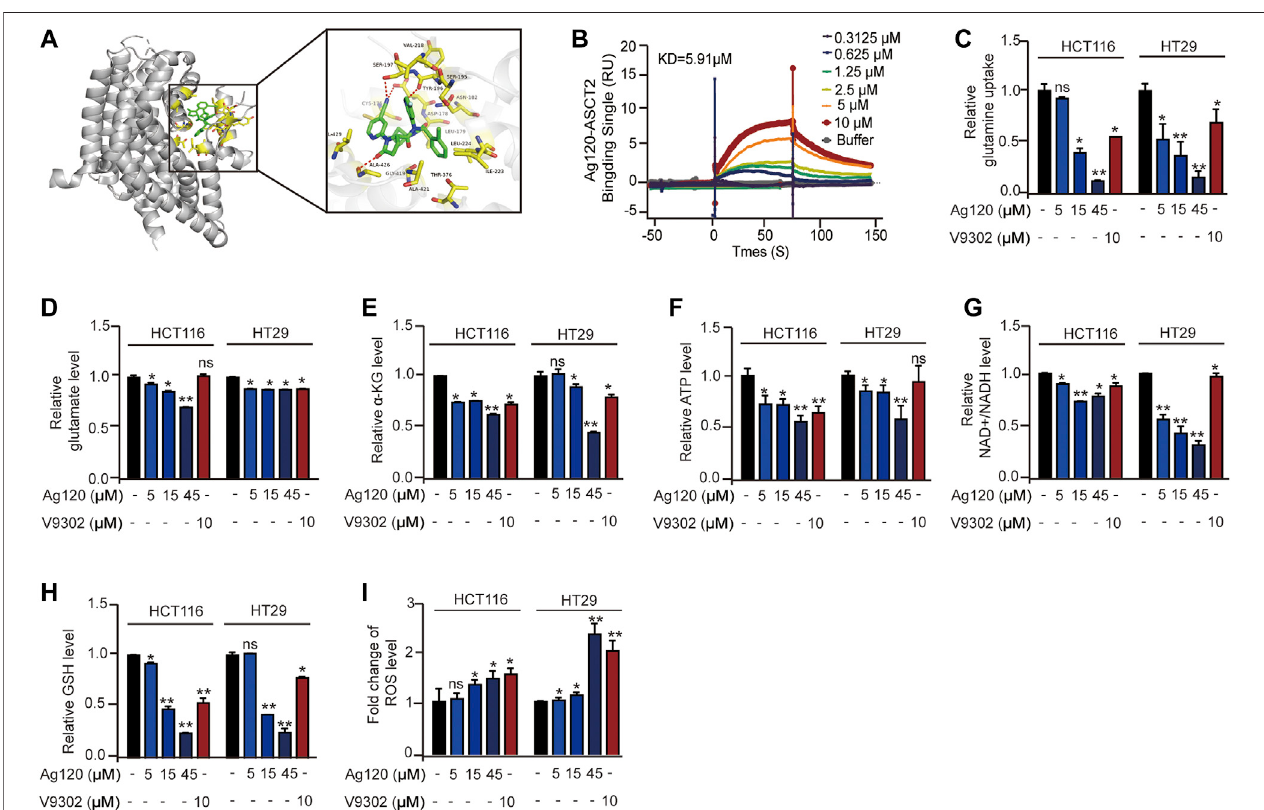
FIGURE 1 | Ag120 binds to isolated ASCT2 protein and inhibits the metabolism of CRC cells. (A) Modeling of Ag120 (green stick) docking superimposed on ASCT2 protein (PDB: 5LLM), with the interacting ASCT2 amino acids represented by orange sticks. Inset shows higher magni fi cation. (B) SPR analysis of the binding af fi nity of Ag120 for puri fi ed ASCT2. (C – I) Intracellular glutamine (C) , glutamate (D) , α -KG (E) , ATP (F) , NAD + /NADH (G) , GSH (H) , and ROS (I) levels in HCT116 and HT29 cells treated with Ag120 or V9302 for 72 h. Mean ± SD of at least three independent experiments. * p < 0.05, ** p < 0.01 by Student ’ s t